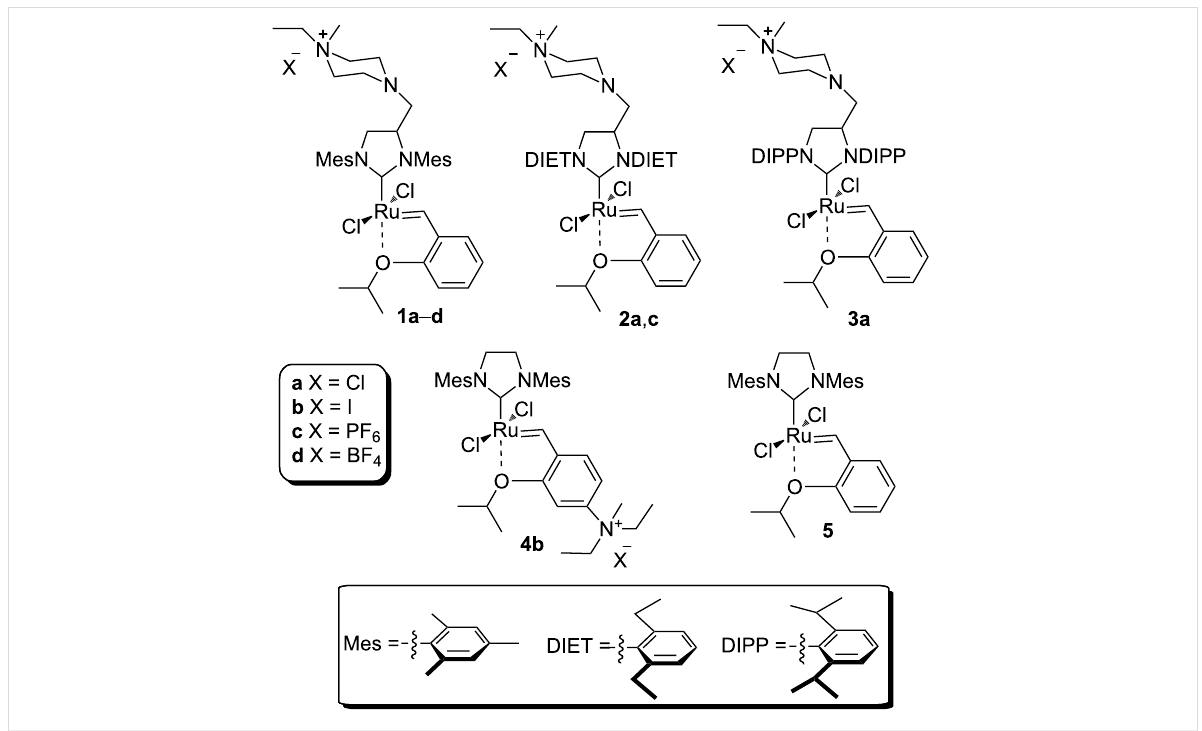
Figure 1: Structures of the Ru-based catalysts used in this